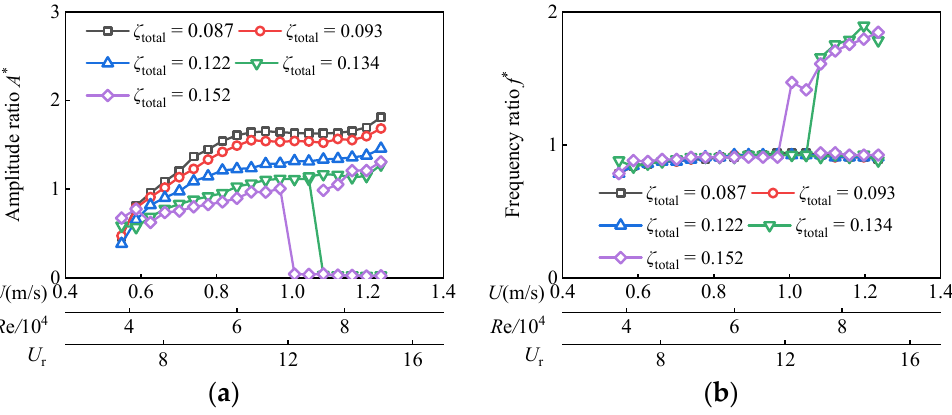
Figure 5. FIM of Cir-T-Att with D = 0.06 m, Re = 2.89 × 10 4 ~6.51 × 10 4 . ( a ) Amplitude ratio. ( b ) Frequency ratio.